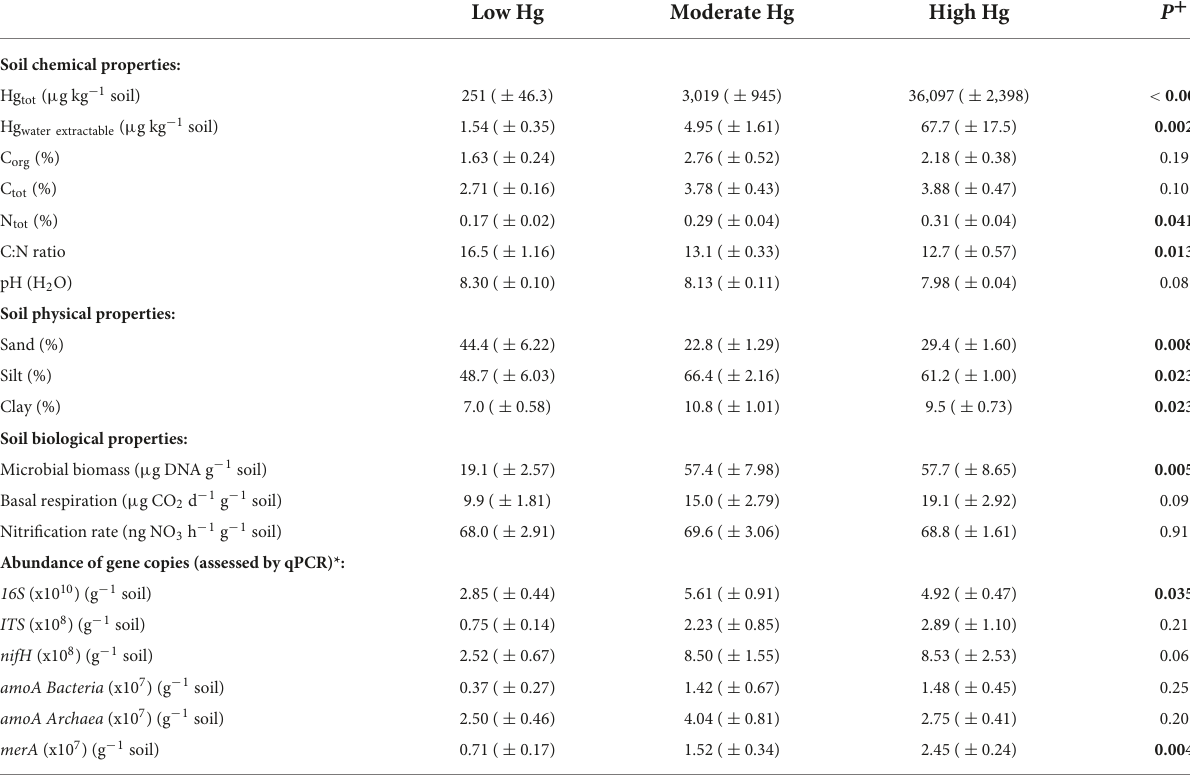
TABLE 1 Mean values of soil chemical, physical and biological properties ( ± SE) for the three Hg contamination levels low, moderate, and high Hg ( n = 4) (compare also with Frossard et al.,